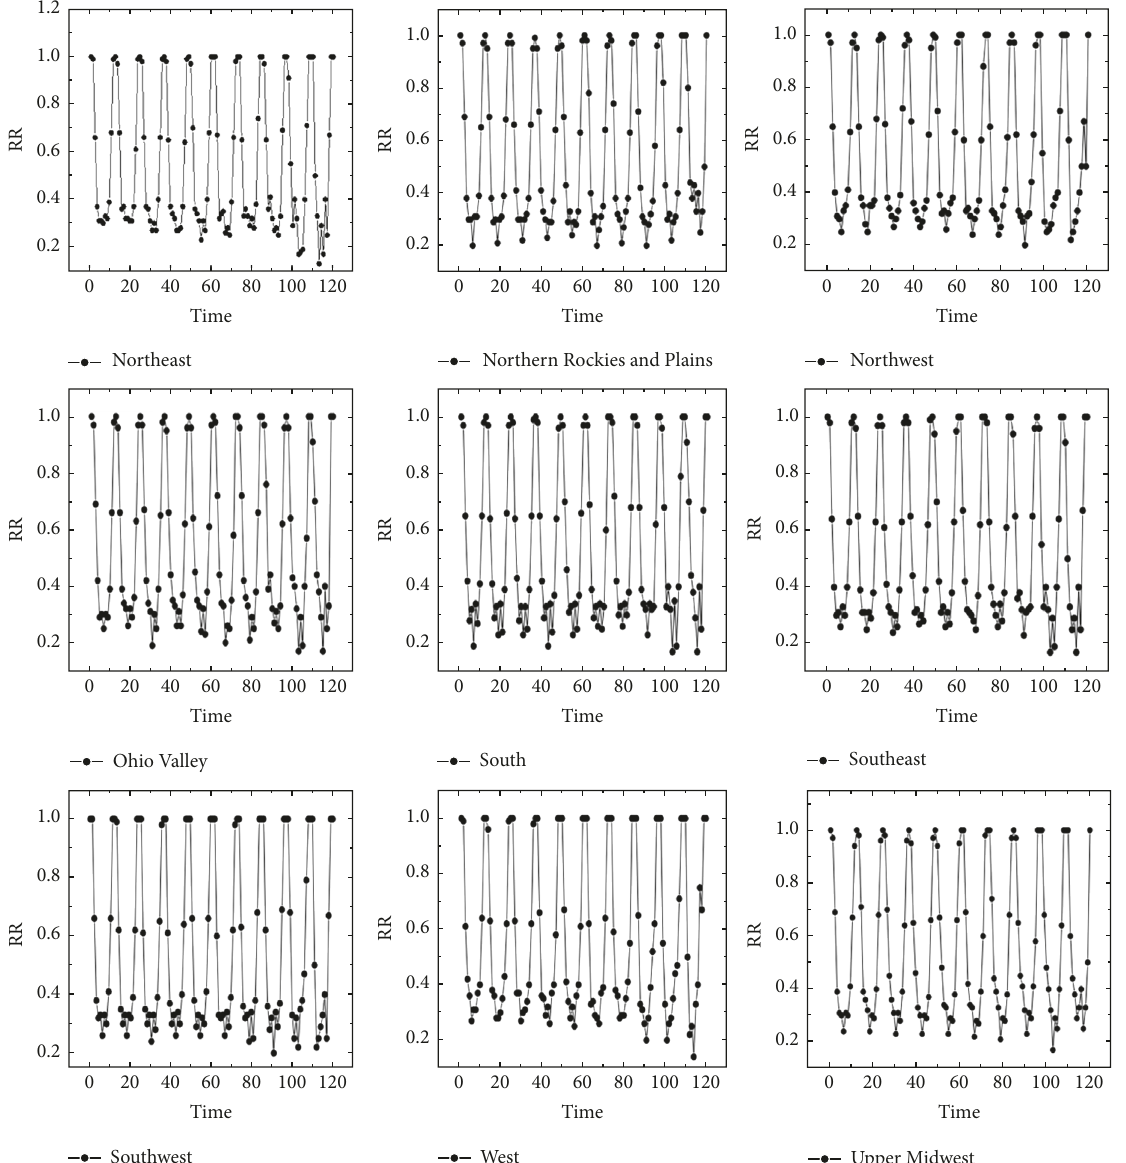
Figure 14: Recurrence rate (RR), 𝑝(𝜏) of each region in the US for 120 months.